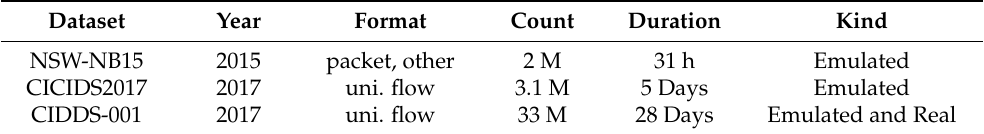
Table 1. Dataset